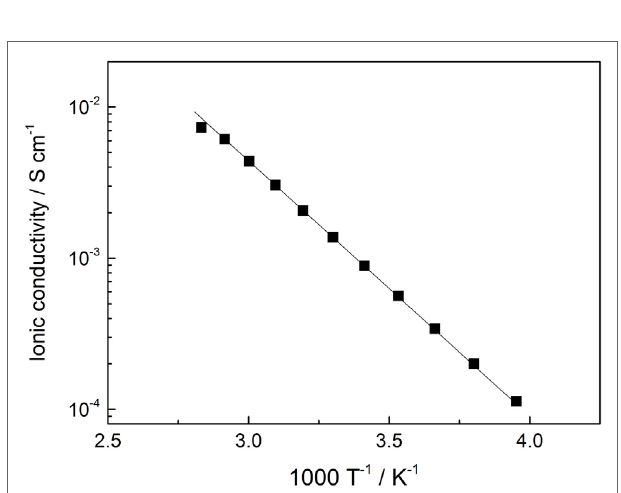
FigUre 3 | arrhenius plot of the ionic conductivity of lii–li 3 Ps 4